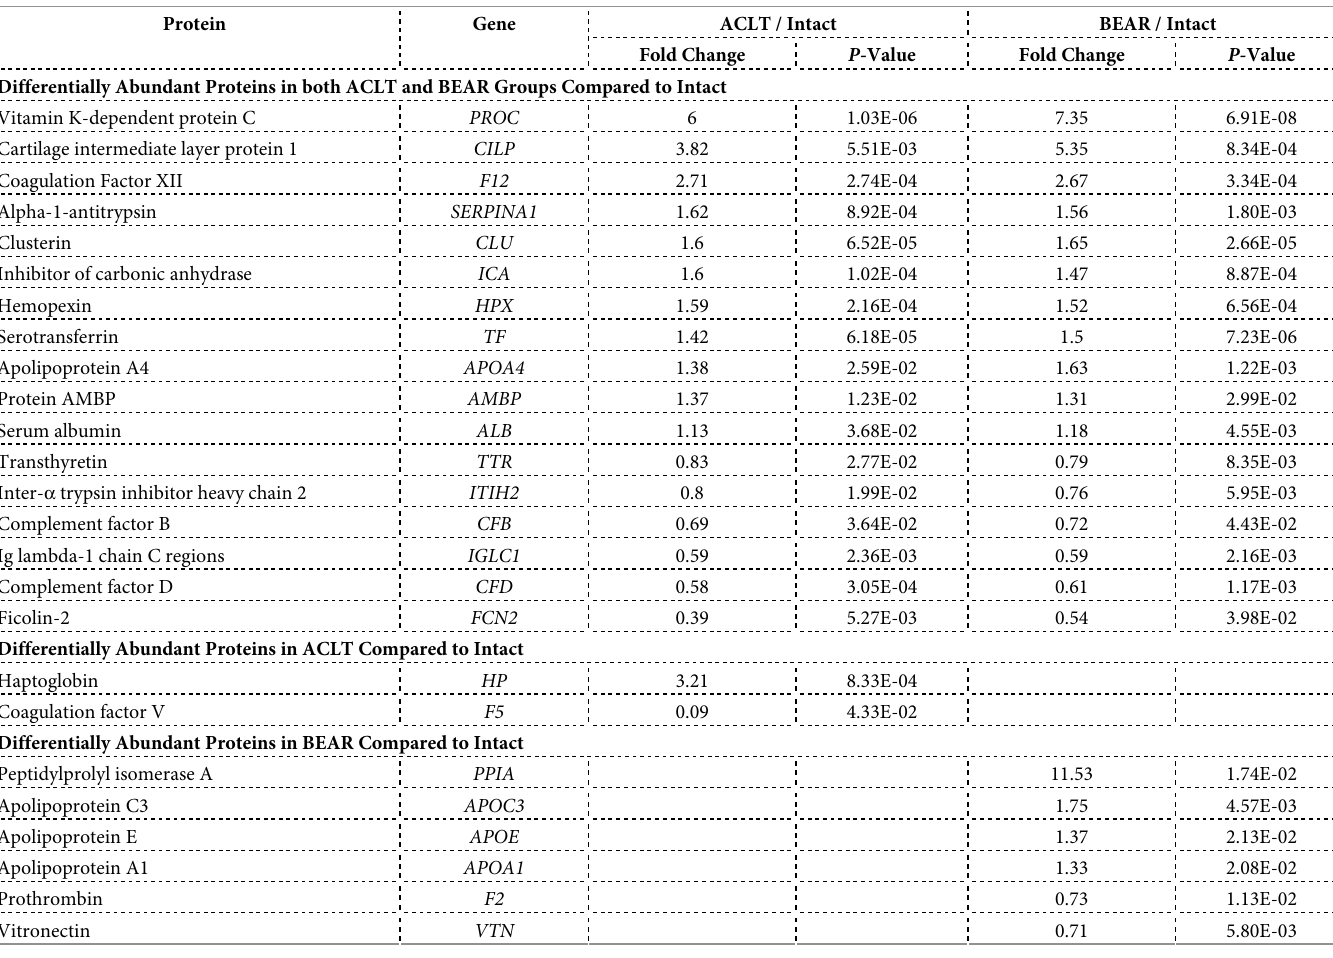
Table 2. Secreted proteins that are significantly different in abundance in ACLT and/or BEAR knees compared to intact group at 6 months. Fold change values rep- resent the ratio of detection in the ACLT or BEAR group versus intact group; thus a fold change greater than 1 reflects higher protein abundance in the synovial fluid of the ACLT or BEAR group and a fold change less than 1 reflects higher protein abundance in the synovial fluid of the intact